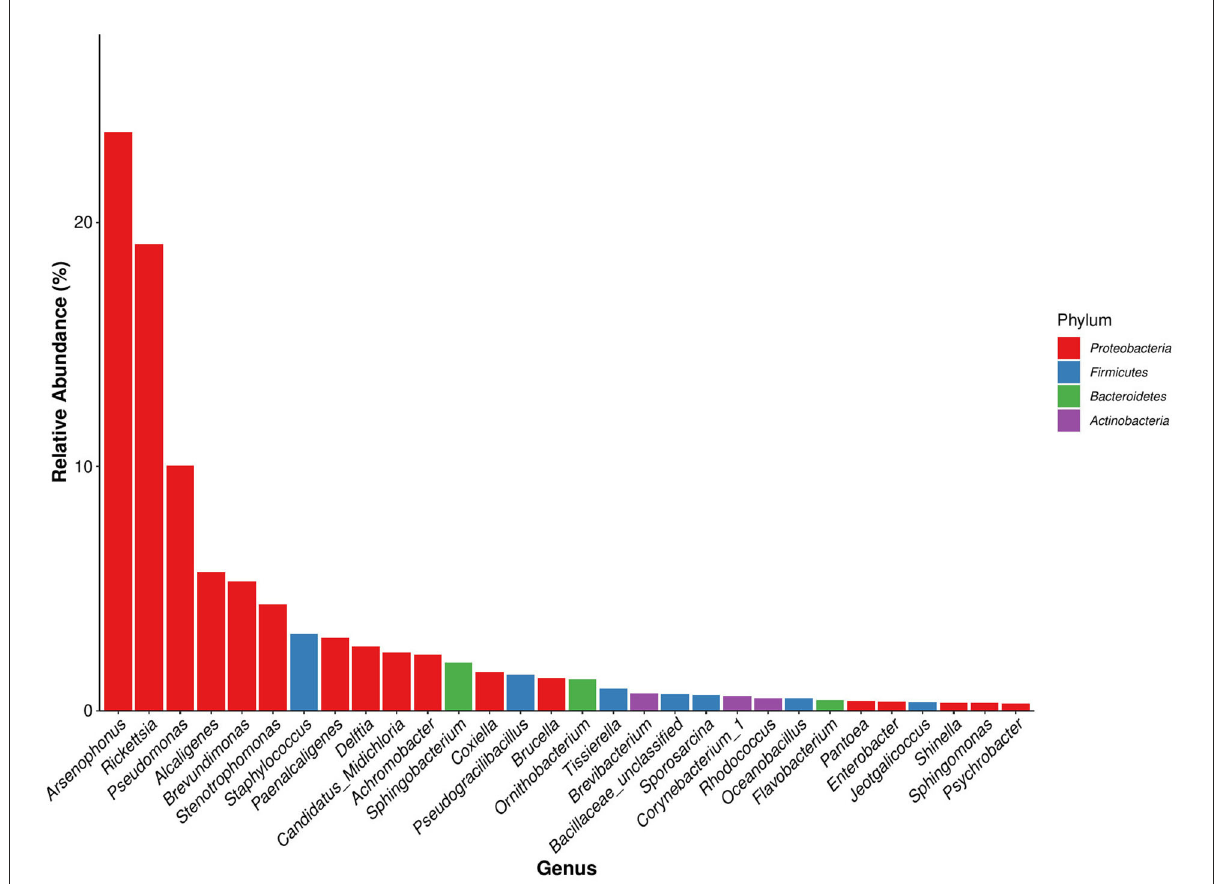
FIGURE5 Dominant species bar plot of bacterial genus of Dermacentor nuttalli (a bacterial genus of the same color indicates that it is derived from the same bacterial